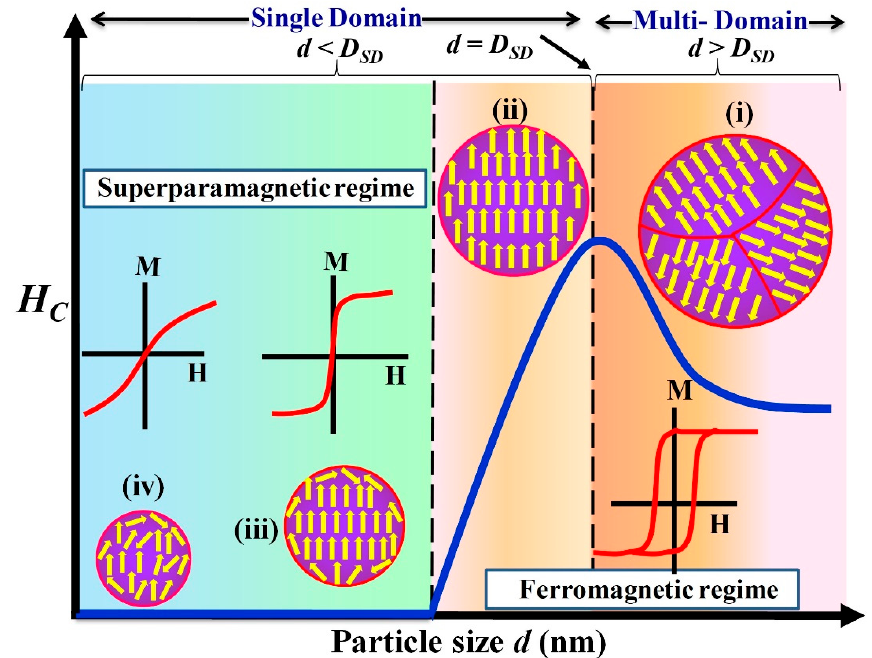
Figure 2. Variation of coercivity ( H C ), spin ordering and the nature of the magnetization curve with MNPs size ‘ d ’. (i) With a decrease of the size of ferromagnetic particles, the H C initially increases and then attains a maximum value at the critical single domain size ( D SD ) due to coherent rotation. (ii) Further, in the single domain regime ( d < D SD ), the H C decreases as the particle size decreases and (iii) becomes zero at the superparamagnetic regime due to the thermal agitation. (iv) Finally, in ultra-small regimes ( d ≤ 3 nm), due to high-spin disorder of elemental spins, the MNPs exhibit a linear relationship between the magnetization and the applied magnetic field.[35]